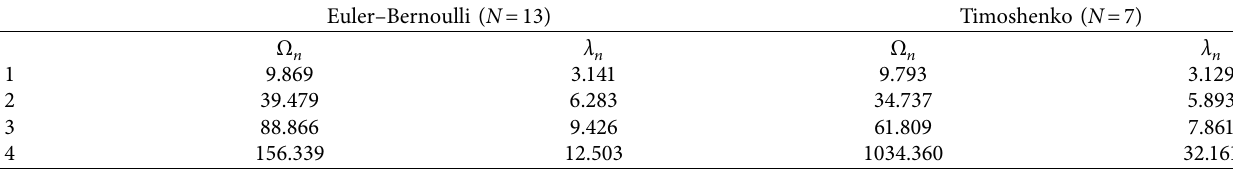
Table 2: Nondimensional and natural frequencies.